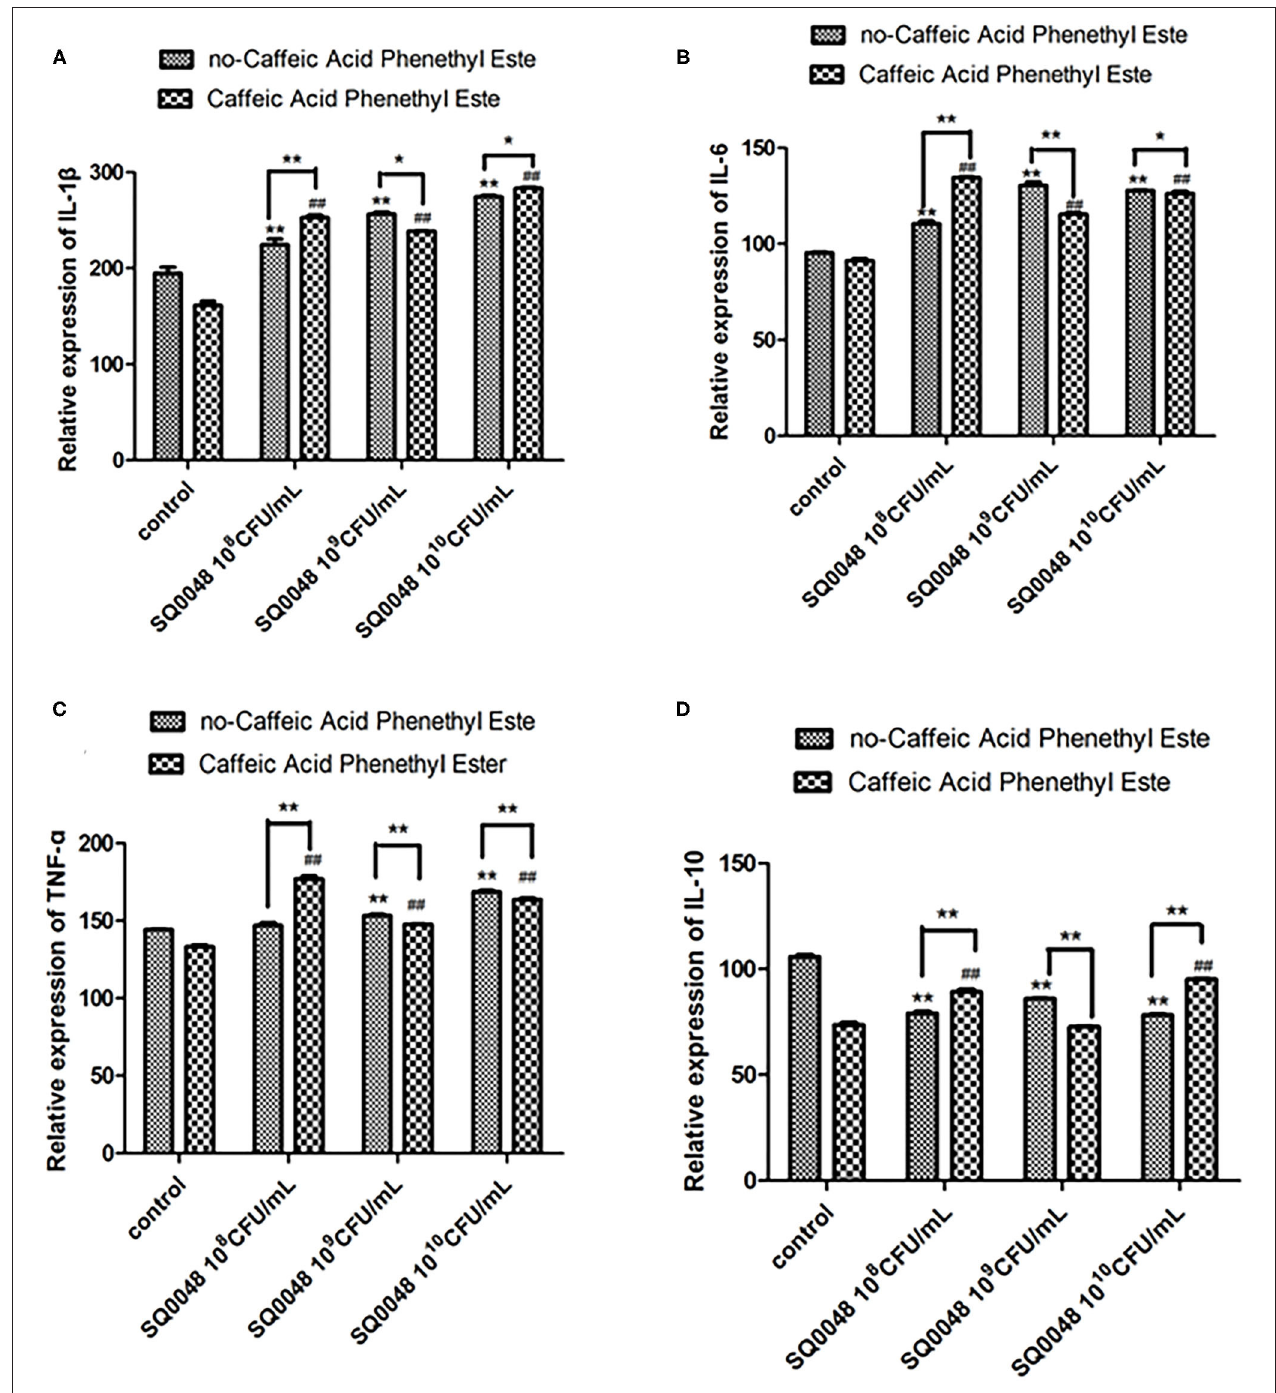
FIGURE 5 | Protein expression levels of IL-1 β (A) , IL-6 (B) , TNF- α (C) , and IL-10 (D) in Caffeic Acid Phenethyl Ester-treated BVECs. All data are shown as means ± SD ( n = 3). * or # indicating P < 0.05 and ** or ## indicating P < 0.01. * refers to the comparison between cells in the cell control group without any treatment and other groups exposed to different concentrations of SQ0048 without inhibitor treatment; it also refers to the comparison between the group without inhibitors and the group with inhibitors at the same concentration of SQ0048; # refers to the comparison between inhibitor control groups exposed to inhibitor but not SQ0048 and other groups exposed to